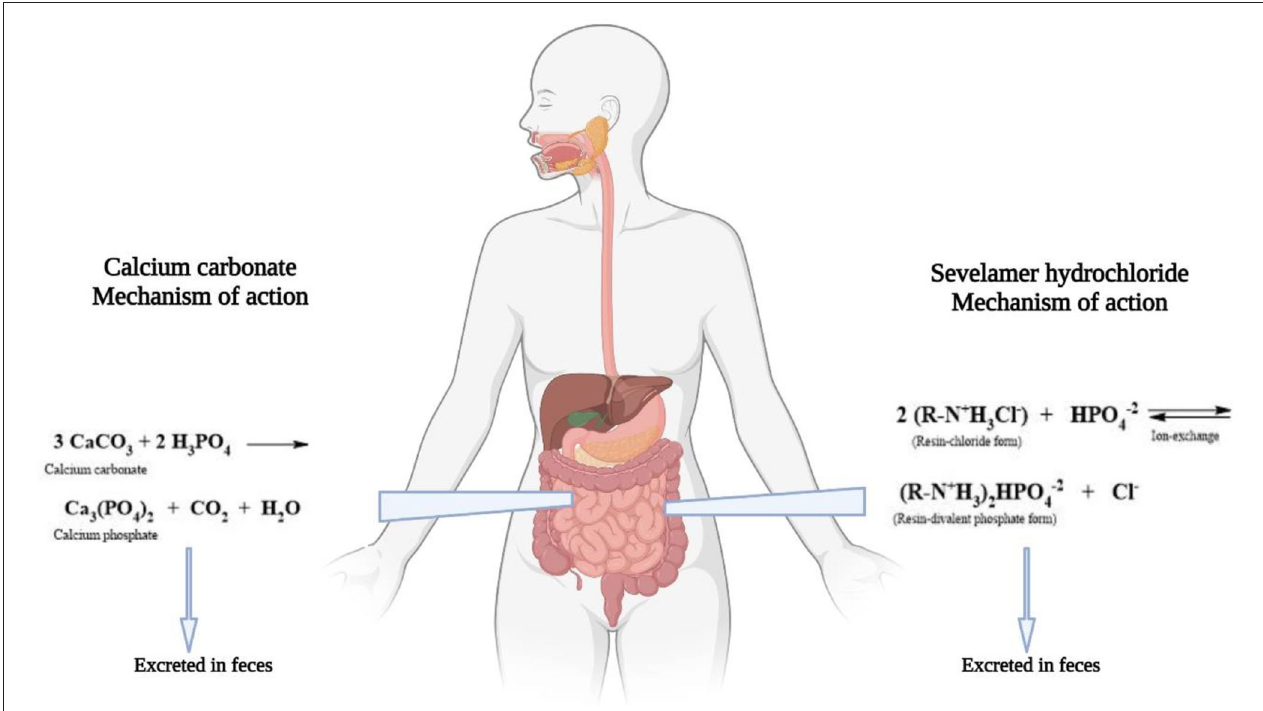
FIGURE 1 | Sevelamer hdyrochloride and calcium carbonate mechanism. Binding of sevelamer hydrochloride and calcium carbonate with phosphate. Right side shows the ion exchange between the resin and the phosphate. Left side shows the reaction between calcium carbonate and